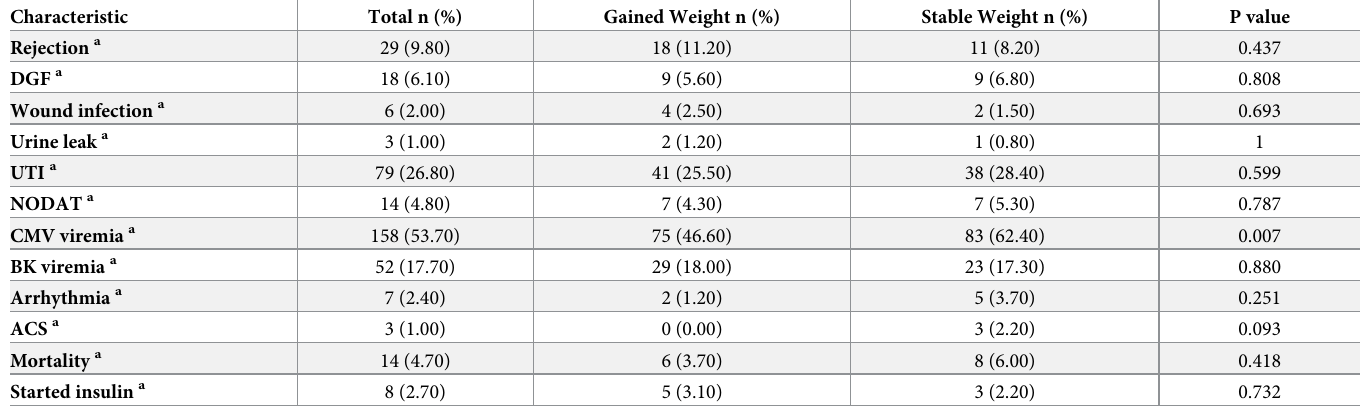
Table 3. Complications.